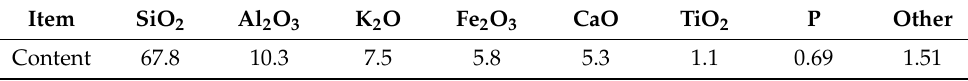
Figure 2. Distribution curves of the particle size ( a ) and the X-ray diffraction (XRD) pattern of the AS ( b ). Table 1. Chemical composition content of AS (unit: